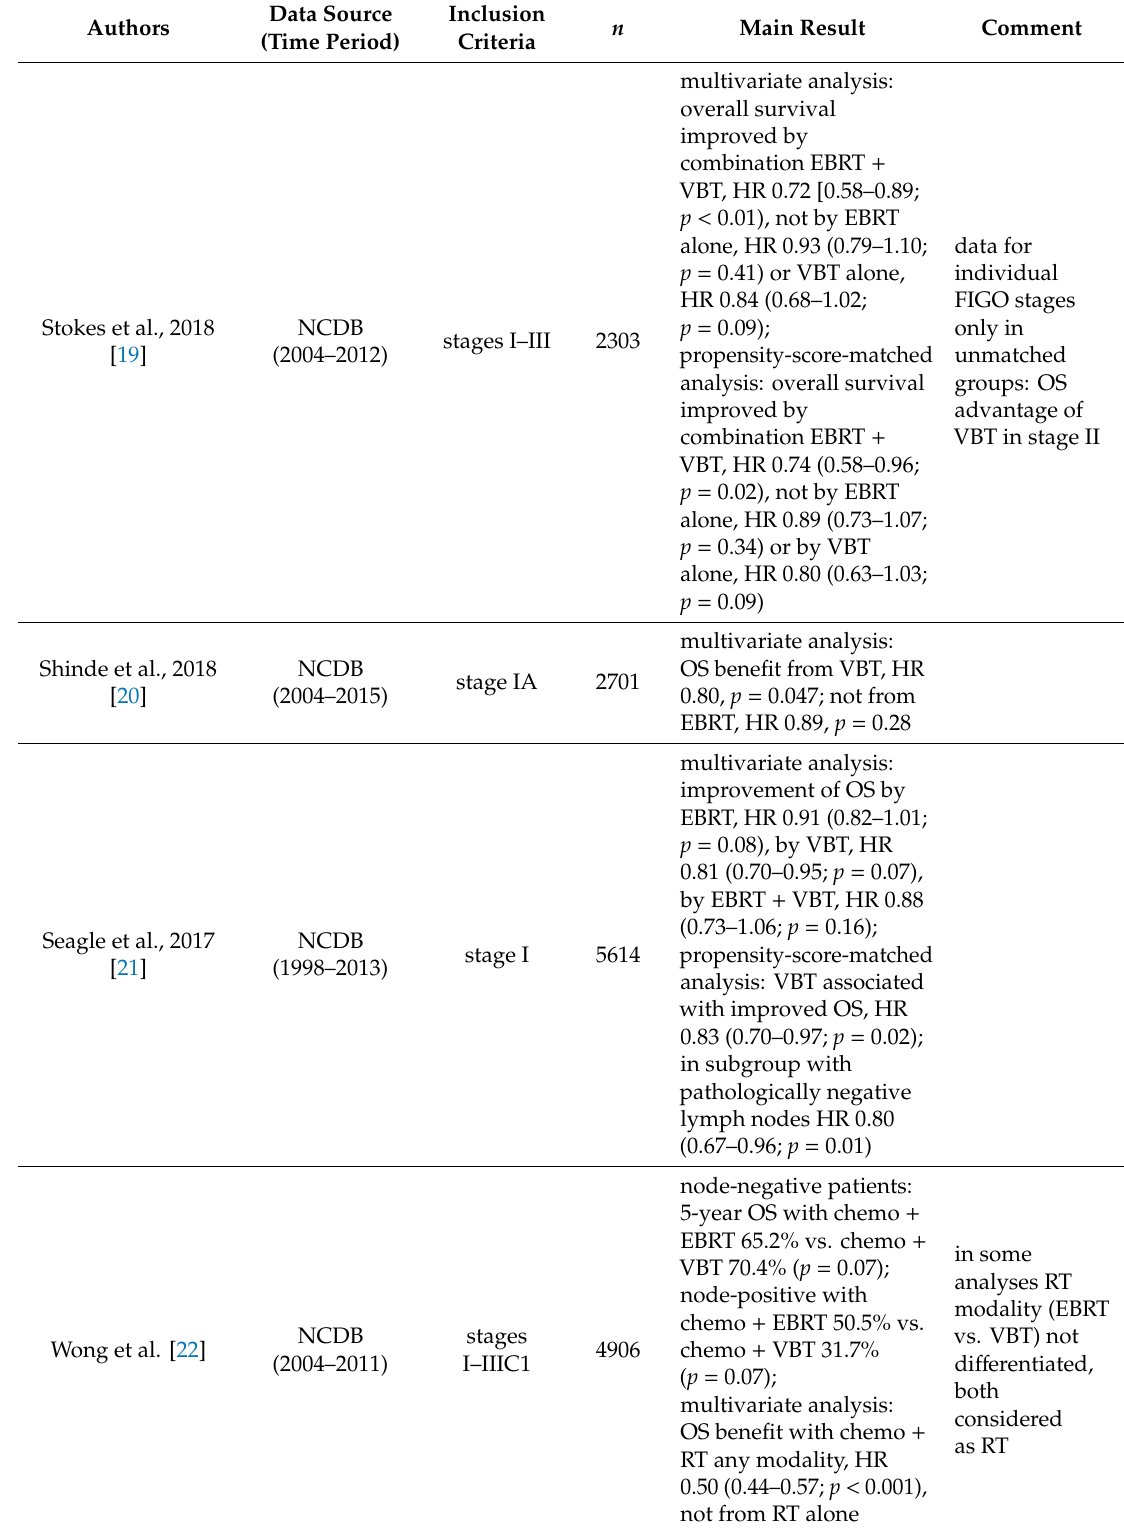
Table 2. Overview of studies of postoperative radiotherapy in uterine carcinosarcoma using data from the United States National Cancer Database (NCDB)